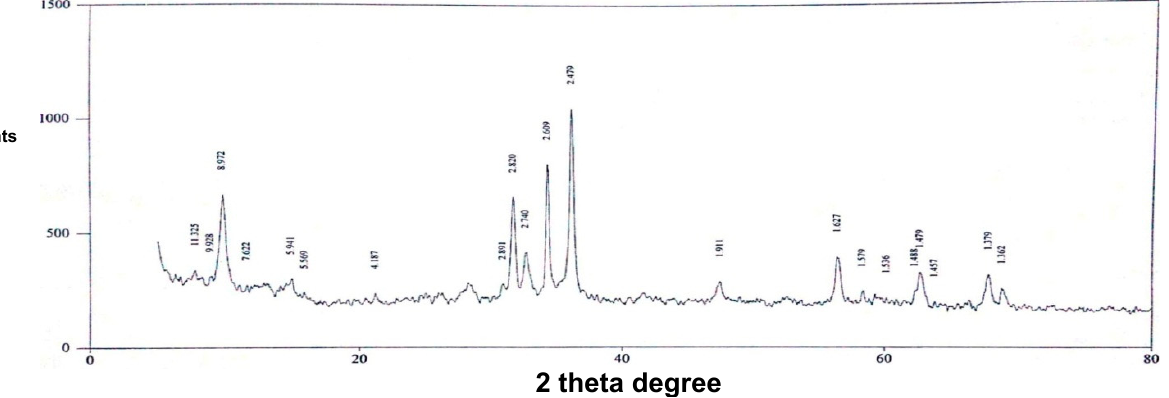
Figure 1. XRD spectra of ZnO nanoparticles used in the experiment. For convenient comparison, the abscissa and ordinate of XRD patterns are displayed at the same row under the same condition and are scaled to the same